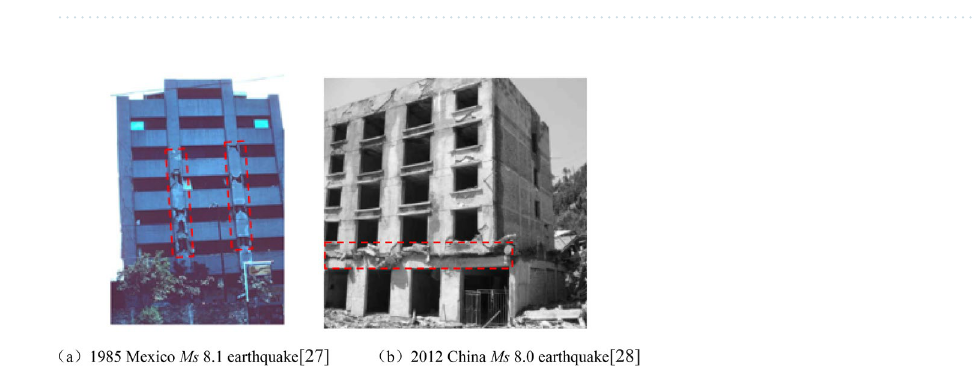
Figure 6. Acceleration time history and Fourier spectrum of top buildings at h = 3 m point of H = 15 m, α = 25°, d = 5 m model.